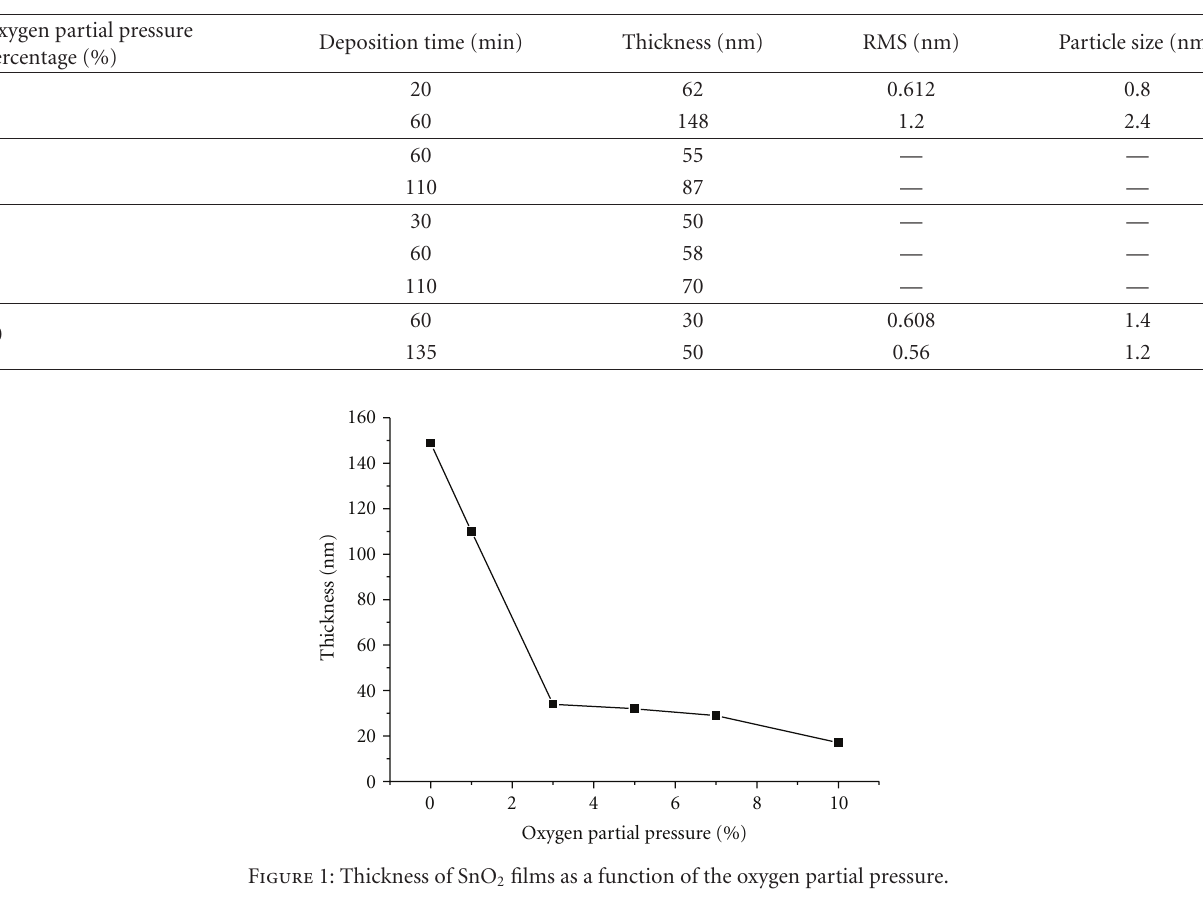
Table 1: Film thickness, surface roughness, and particle size of SnO 2 films deposited with di ff erent conditions.